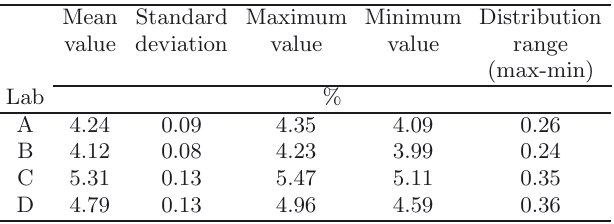
Table 3. Distribution ranges of tensile strains ( ε ) for the par- ticipant laboratories.